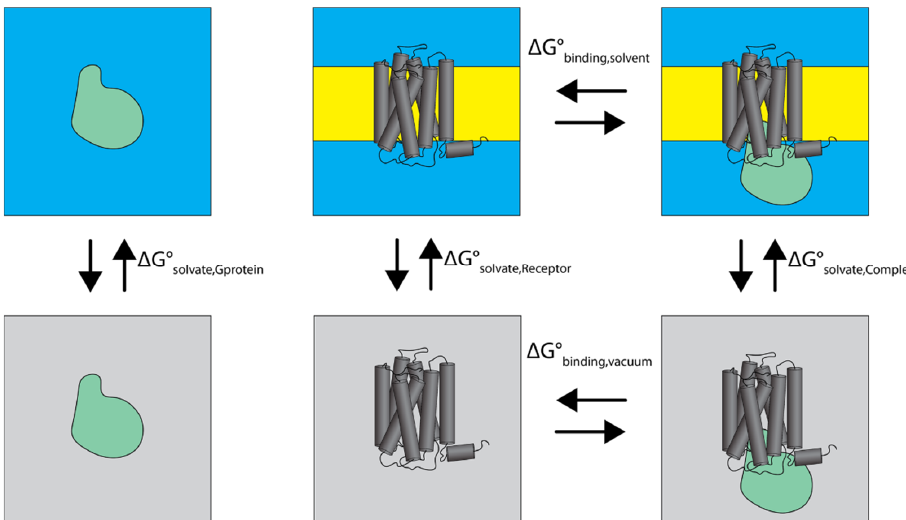
Figure 9. The MMPBSA thermodynamic cycle of the G protein (green blob) in aqueous phase (blue) binding to the G-protein-coupled receptor (GPCR) (dark gray) embedded in the membrane (yellow). The lower three panels refer to vacuum conditions, shown in light gray. The free energy change for di ff erent transitions is shown as ∆ G ◦.